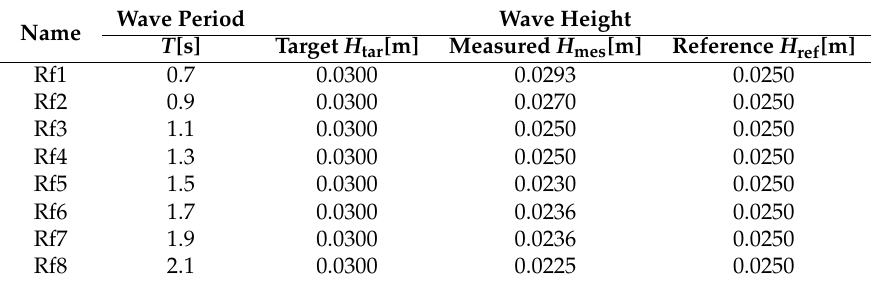
Table 3. Description of the realized regular wave sea states in terms of wave period and wave height as measured in the basin without the model.